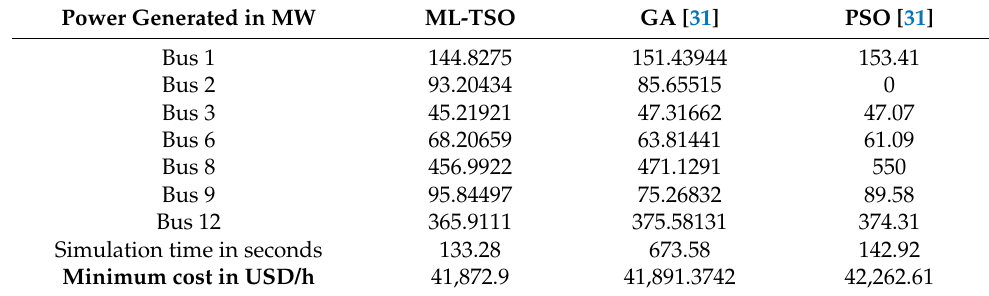
Table 5. Minimum fuel cost and optimal design variables for the IEEE 57-bus system.